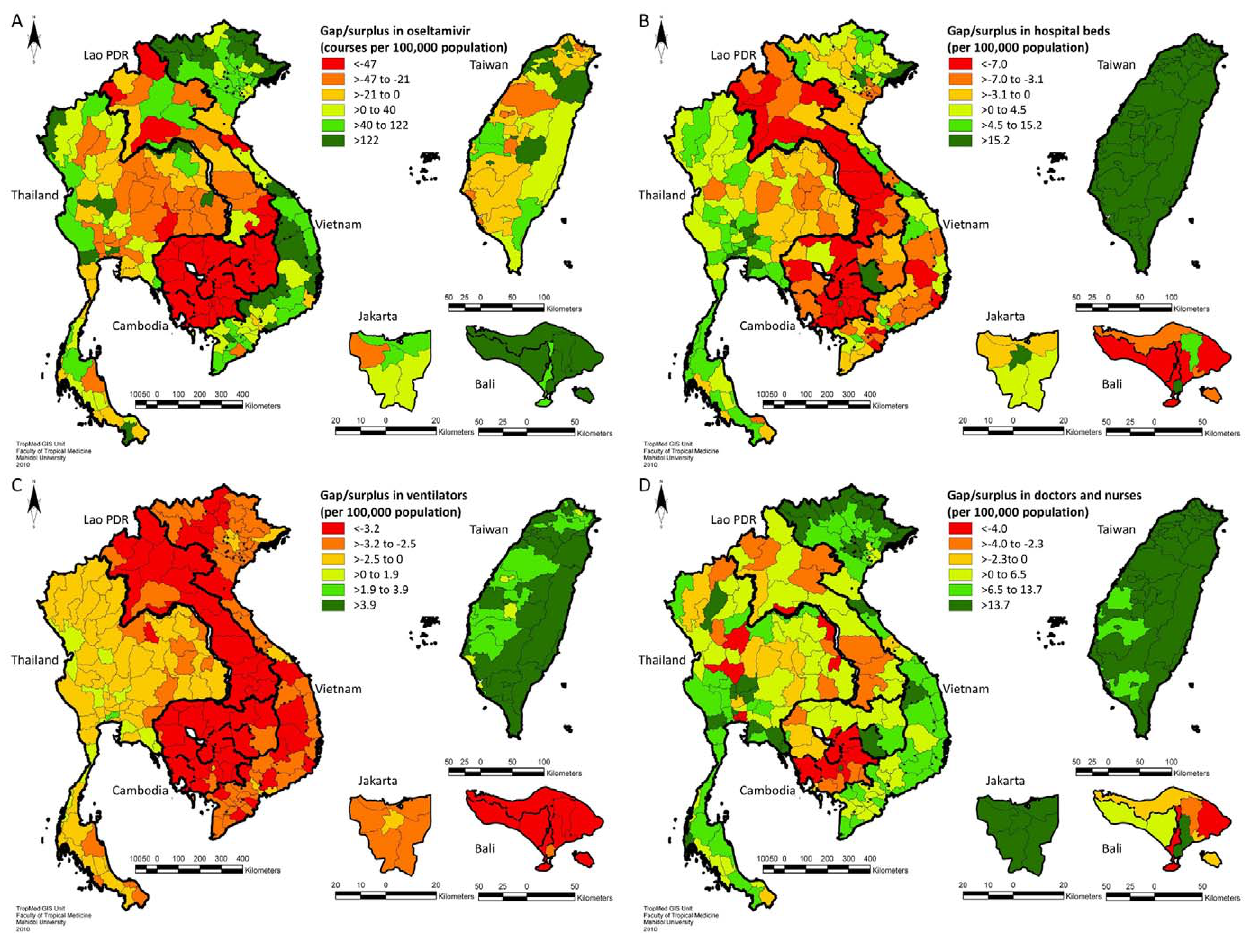
Figure 1. Geographical distribution of estimated health system resource gaps for a modeled pandemic influenza scenario. Gaps are mapped for oseltamivir (A), hospital beds (B), mechanical ventilators (C), and healthcare workers (pooled number of doctors and nurses; D). Areas shaded according to values # 0 represent areas where a resource gap is predicted. Gaps are standardized by population size and mapped at province level for Cambodia, Lao PDR, Thailand, and Vietnam, at county level for Taiwan, and at district level for Jakarta and Bali in Indonesia.